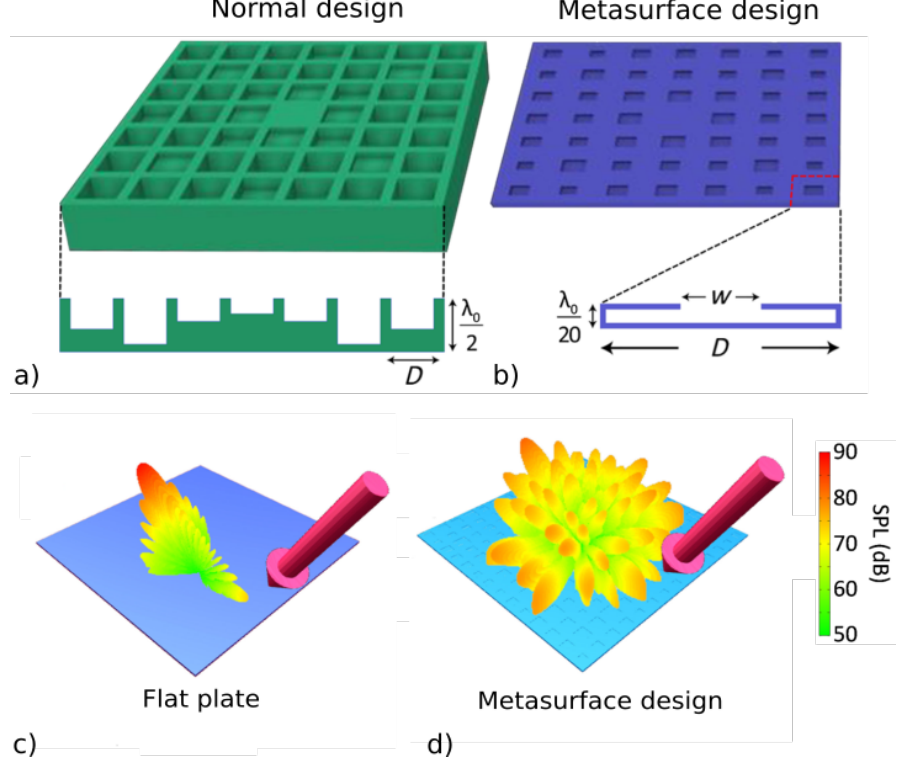
Figure 1. Metasurface design of a Schroeder Diffuser from [26]: diffuse scattering is achieved through a deep sub-wavelength metasurface. Each cell adds a different and random arranged phase-shift in the reflected field. In ( a , b ) the standard and the metasurface designs are compared. The simulated far-field scattering pattern for a flat plate and for the metasurface diffuser are shown in ( c , d ) in terms of sound pressure level (the arrow indicates the incident acoustic perturbation) evidencing the achieved